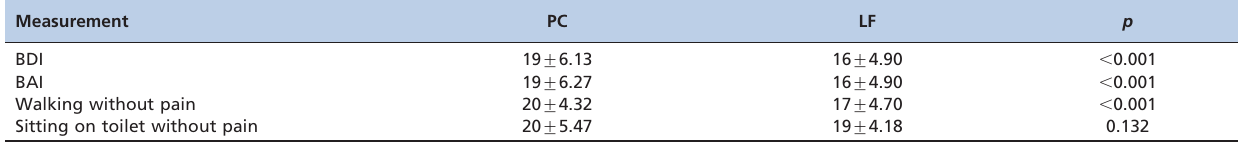
Table 2 - Comparison of BDI and BAI scores, time to walking without pain, and time to sitting on a toilet without pain between